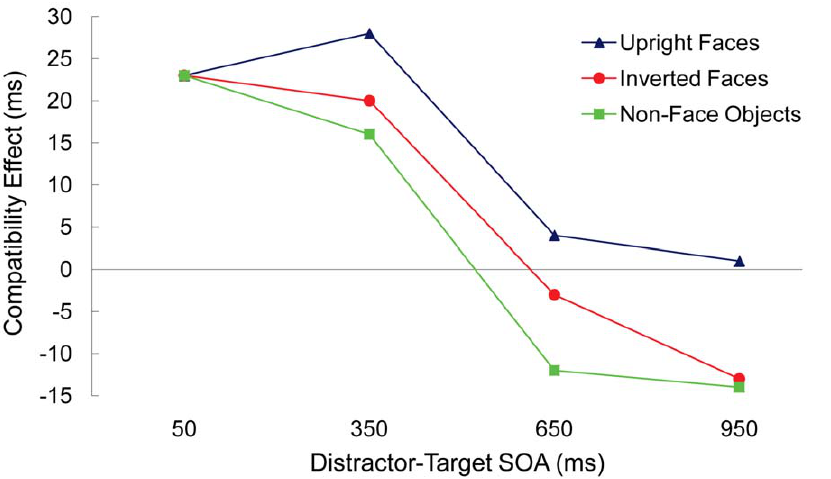
Figure 2. For each version (non-face objects, upright faces, and inverted faces), the size of the compatibility effect in milliseconds for each distractor-target SOA. The compatibility effect equals response latencies on incompatible trials minus response latencies on compatible trials. doi:10.1371/journal.pone.0020544.g002 PLoS ONE |